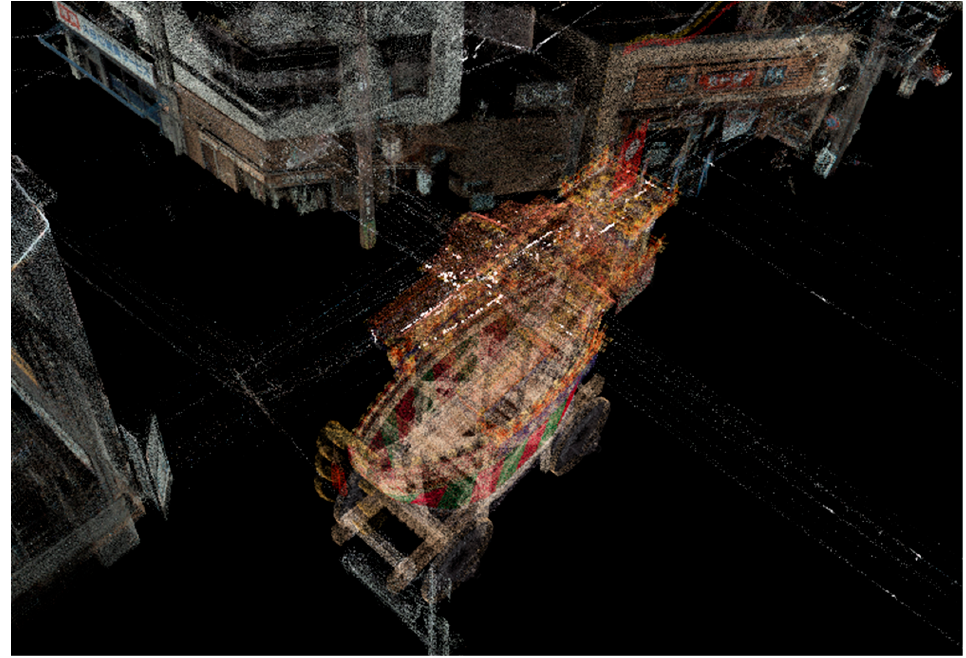
Figure 12. Transparent collision visualization similar to Figure 8. Only the collision areas of the Ofune-hoko float are given the white highlighted color.